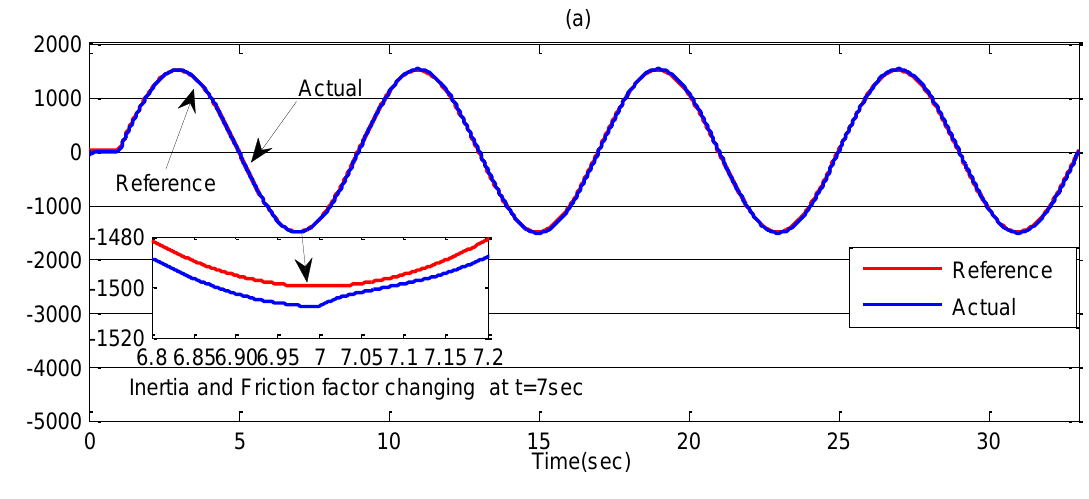
Figure 11. Simulated speed responses based IM drive in Case-3 ; ( a ) the tuned PI controller, ( b ) the conventional BLFC controller, and ( c ) the proposed NBLFC